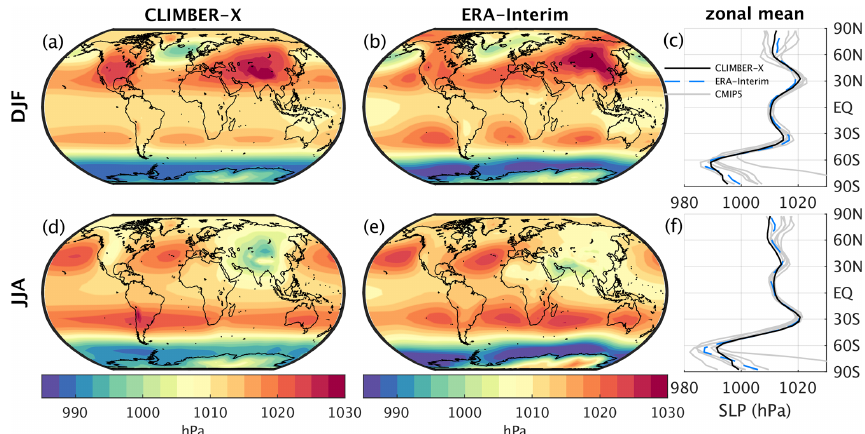
Figure 4. Sea-level pressure in CLIMBER-X for (a) DJF and (d) JJA compared to ERA-Interim reanalysis (Dee et al., 2011) (b, e) . The zonal mean is additionally compared to CMIP5 models in panels (c) and (f) .